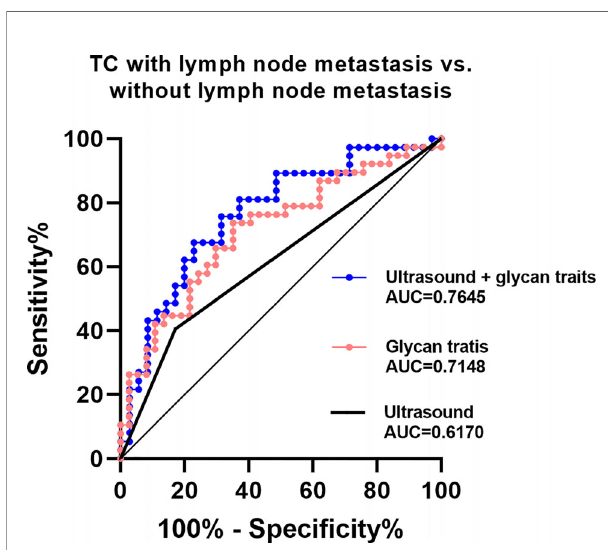
FIGURE 5 | ROC curve analysis for derived glycan traits which showed associations with lymph node